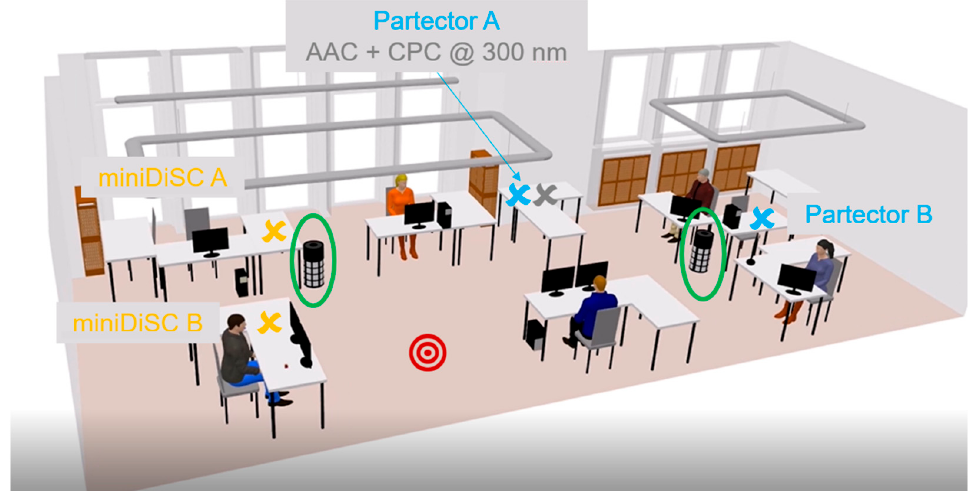
Figure 1. Virtual twin of the office room, with the red circle denoting the location of the atomizer.